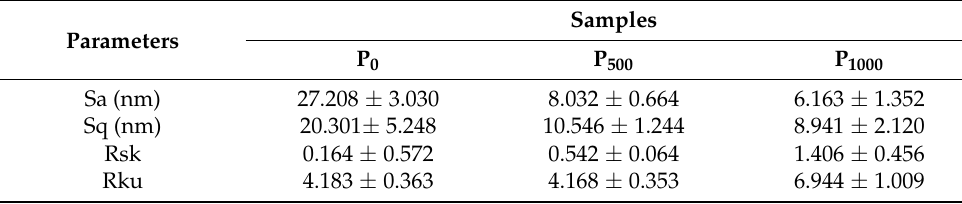
Table 1. Surface parameters (Sa, Sq, Rsk, and